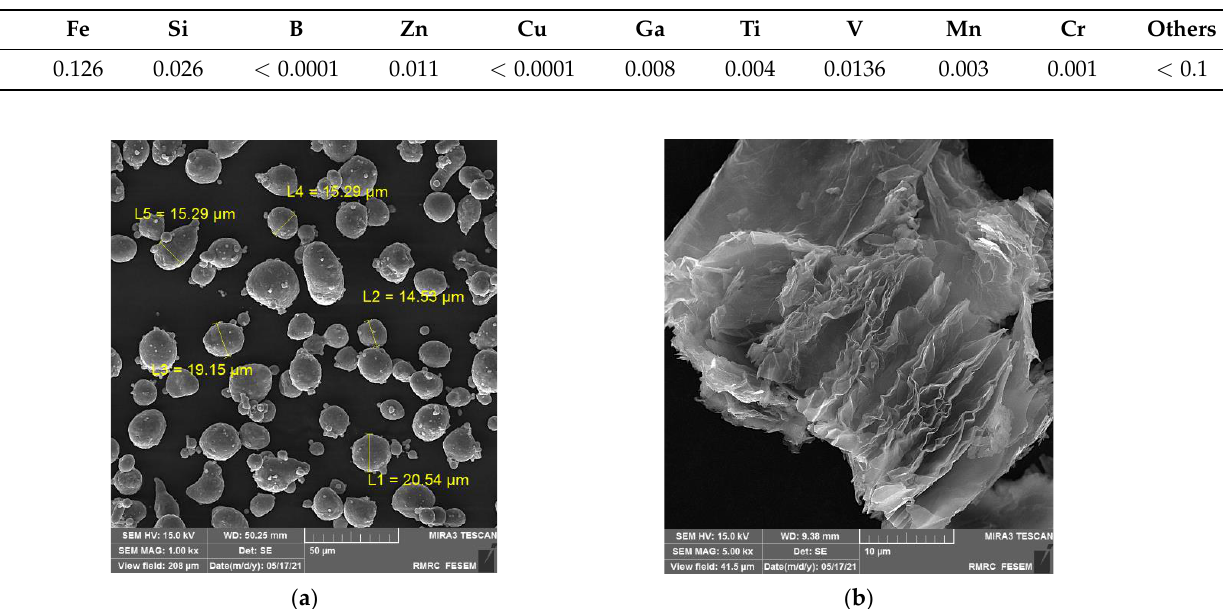
Figure 1. Microscopy image of ( a ) aluminum powder ( b ) graphene. Table 1. Chemical composition of Al 1350 in weight percentages.